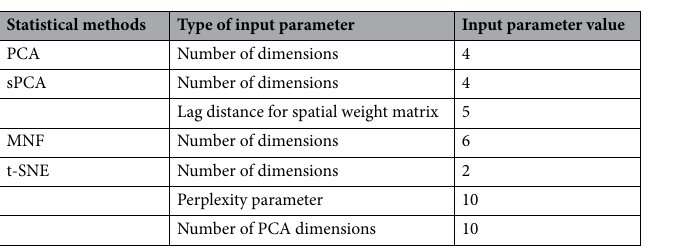
Table 1. Input parameter for different statistical